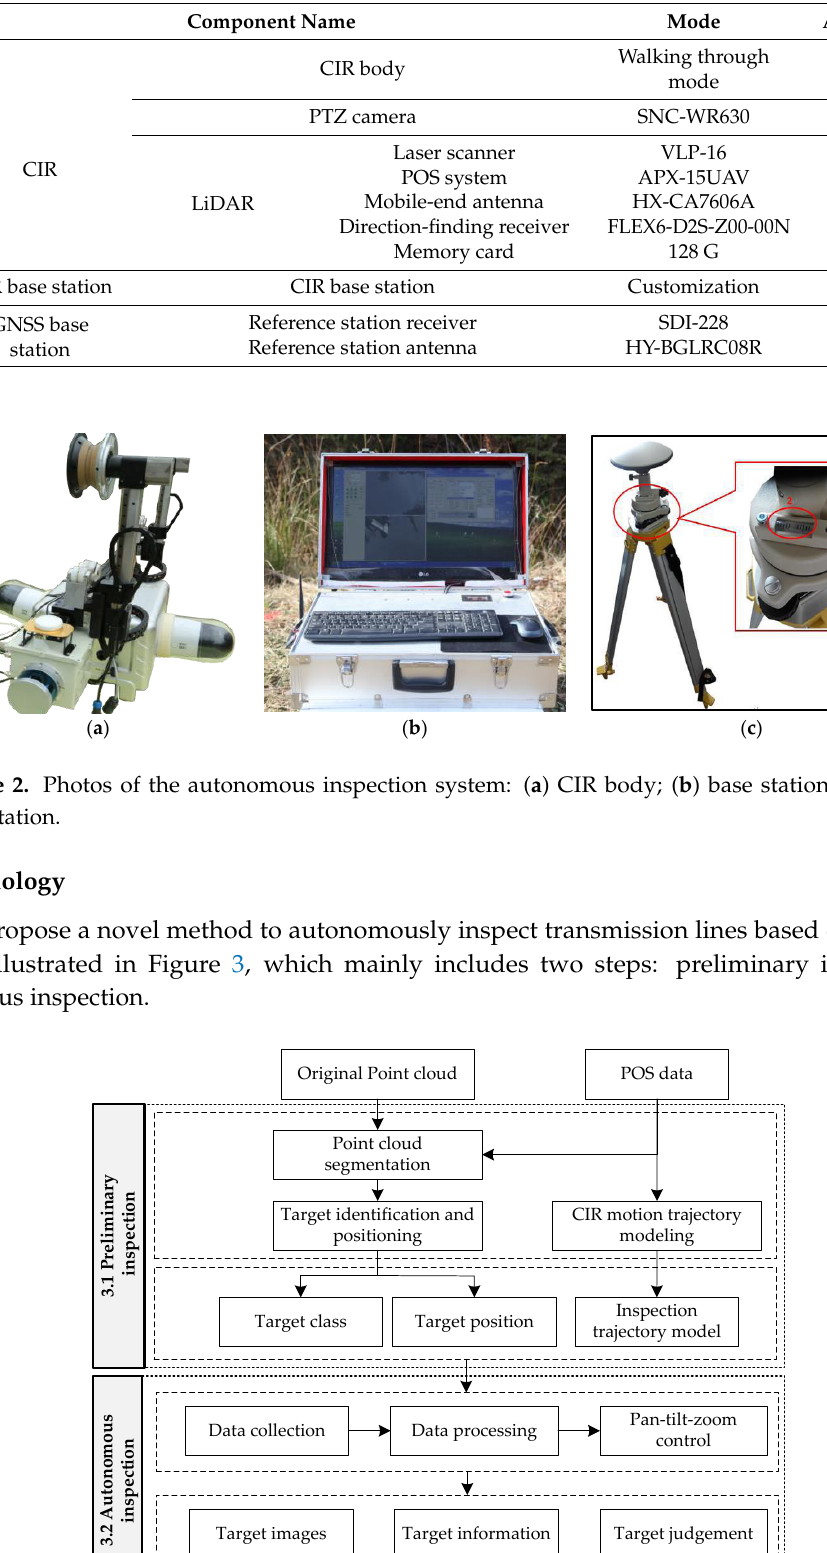
Figure 3. Technical framework of the proposed autonomous inspection method.